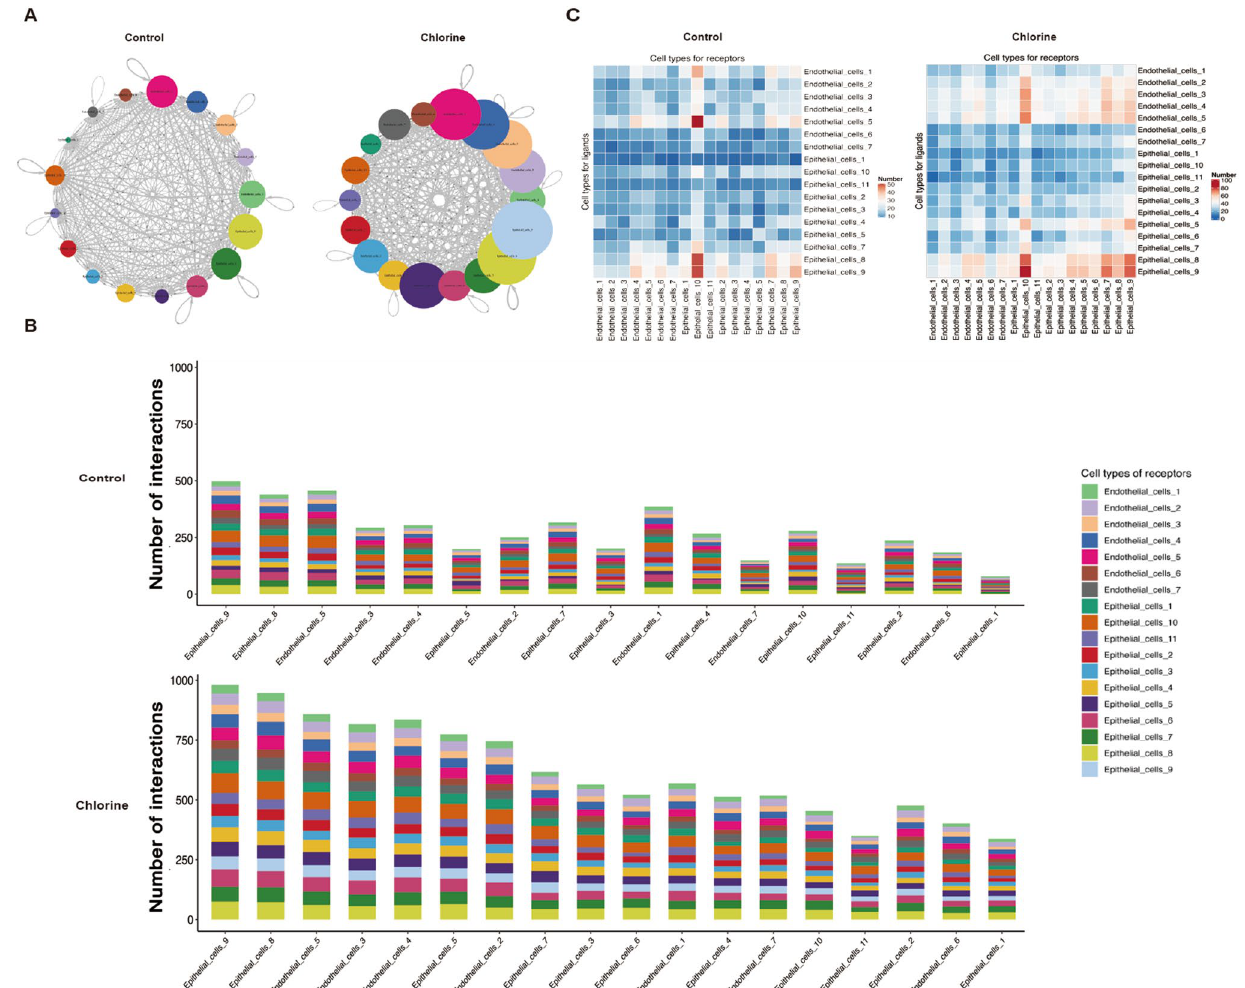
Figure 5. Intercellular epithelial–endothelial cells communication in mice lung tissues. ( A ) Capacity for intercellular communication among epithelial and endothelial cells. The nodes in the figure represent different cell types, the arrows represent the interaction signals from ligand cells to receptor cells, and the numbers on the arrows represent the number of significant ligand–receptor interaction pairs detected between different cell types. ( B ) The number of ligand receptors for epithelial–endothelial cells1interactions was shown by stacked bar graphs. ( C ) Heatmap shown the total number of interactions between cell types. The redder the color, the higher the number of interacting ligand–receptor. N control group, C Cl 2